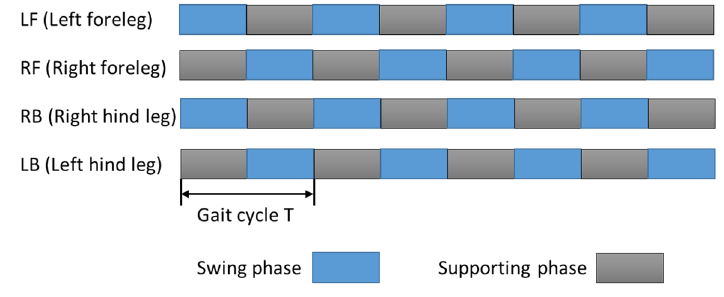
Figure 9. Trot gait phase diagram of quadruped robot.